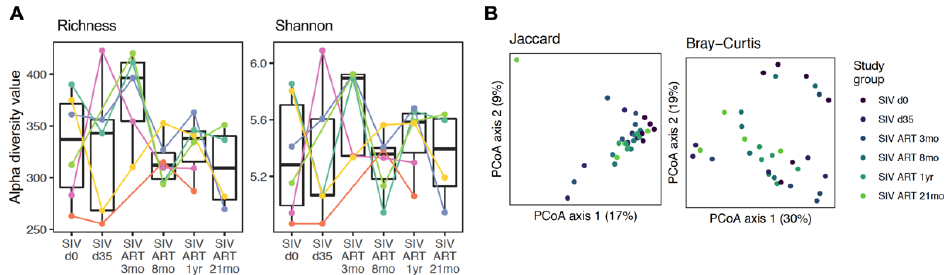
Figure 3. Diversity in fecal samples. ( A ) Alpha diversity, measured by observed species in the Richness and Shannon index, is plotted for animals at baseline (SIV.d0), at d35 post-SIV infection, and at 3 mo, 8 mo, 12 mo, and 21 mo ART. Each animal is represented by a different color. The line inside the box represents the median, while the whiskers represent the lowest and highest values. Linear mixed effects models showed no difference for species with Richness or Shannon diversity between the time-points. ( B ) Principal coordinates analysis (PCoA) plots of Jaccard and Bray – Curtis distances to assess beta diversity at different time-points of SIV-ART. No statistically significant differences were observed between the different ART time-points using the PERMANOVA test.